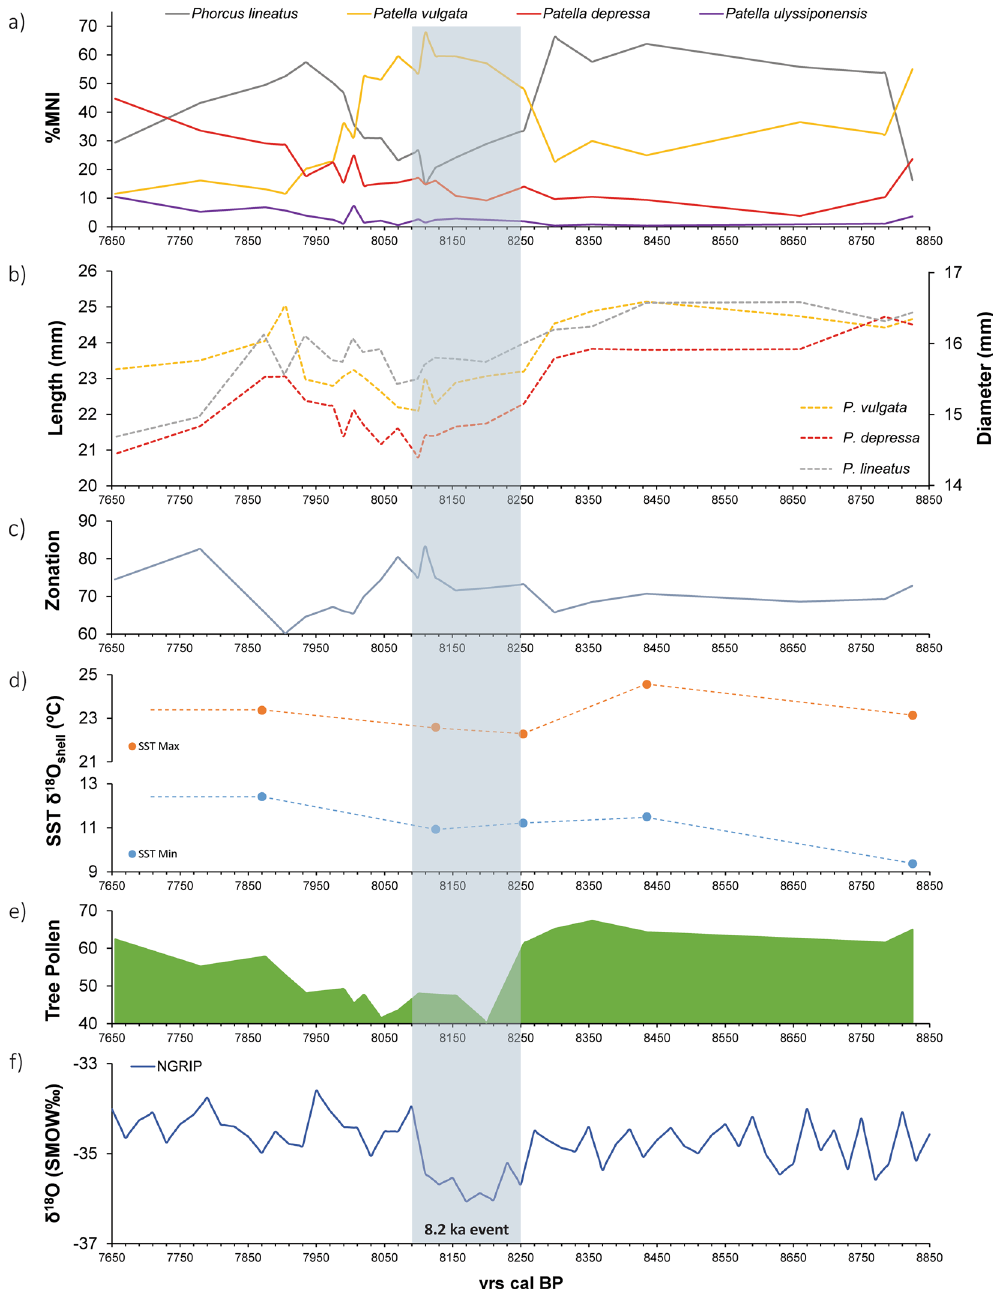
Figure 4. ( a ) Relative representation of the four main marine mollusc taxa recovered from El Mazo site over time ( P. lineatus , P. vulgata , P. depressa , and P. ulyssiponensis ). ( b ) Average shell size variations on P. lineatus , P. vulgata and P. depressa through time. ( c ) Percentage of P. vulgata shells collected in the lower intertidal zone over time deduced from L/H ratios 37 . ( d ) Maximum and minimum estimated SST from δ 18 O shell values for different stratigraphic units through shell midden sequence. ( e ) Percentage of arboreal pollen over time in N Spain 38 . ( f ) δ 18 O from the Greenland NGRIP ice core 39 . Blue bar shows 8.2 k event duration according to the Greenland NGRIP ice core 6